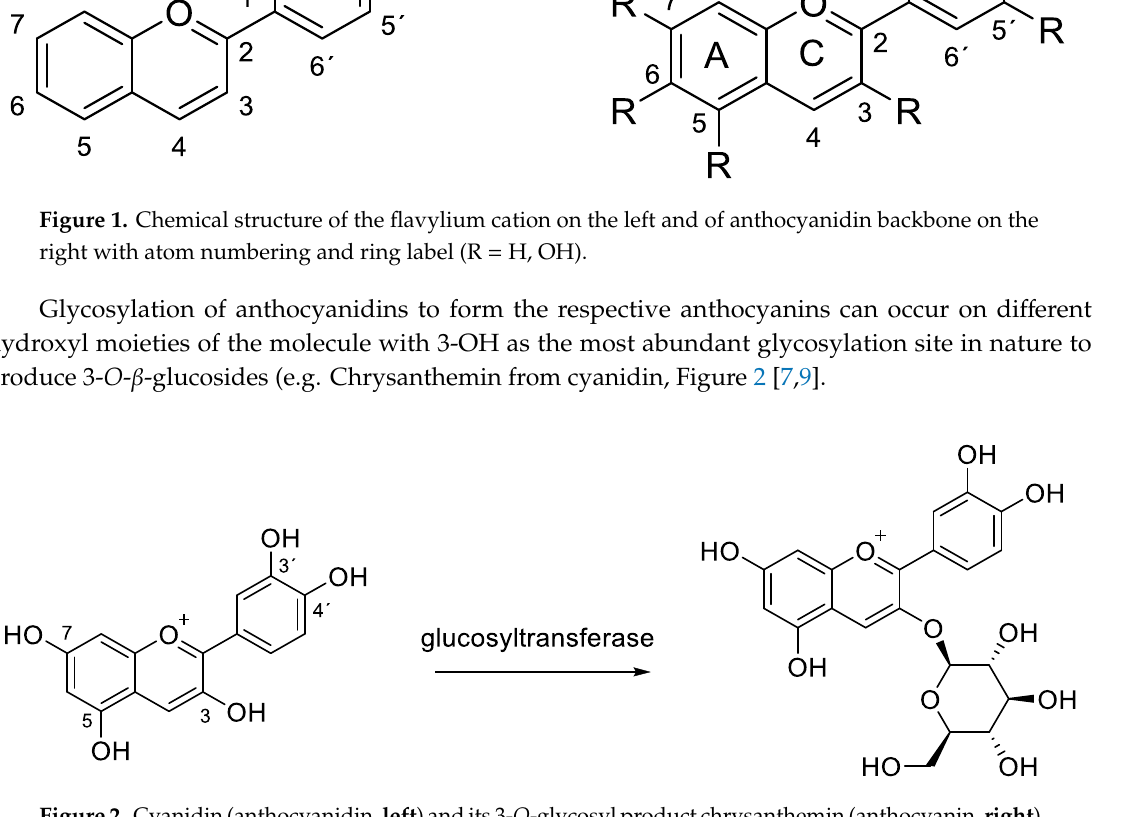
Figure 2. Cyanidin (anthocyanidin, left) and its 3- O -glycosyl product chrysanthemin (anthocyanin, right) derived from the enzymatic activity of glucosyltransferase.